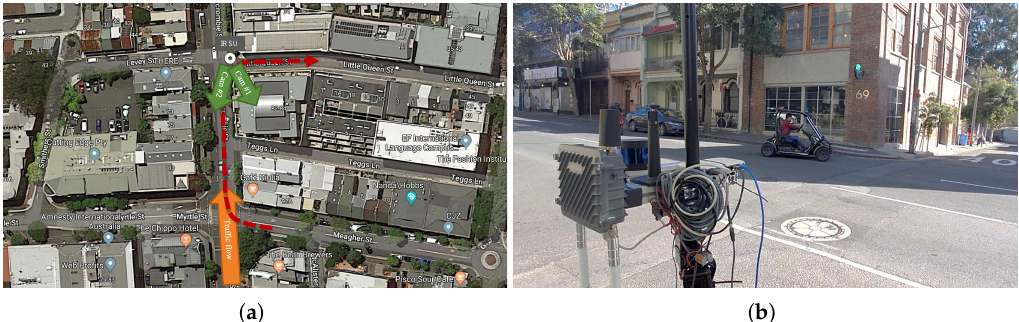
Figure 13. Experiment setup at the intersection of Abercrombie St and Little Queen St. In ( a ), the IRSU was setup facing south of Abercrombie St. The car traffic flow was going north on this one-way street. The trajectory of the CV is denoted by a dashed red line, which indicates that the CV turned from Meagher St to Abercrombie St, followed by Little Queen St. In ( b ), CPMs were transmitted from the IRSU to the moving CV through Cohda Wireless MK5 devices.